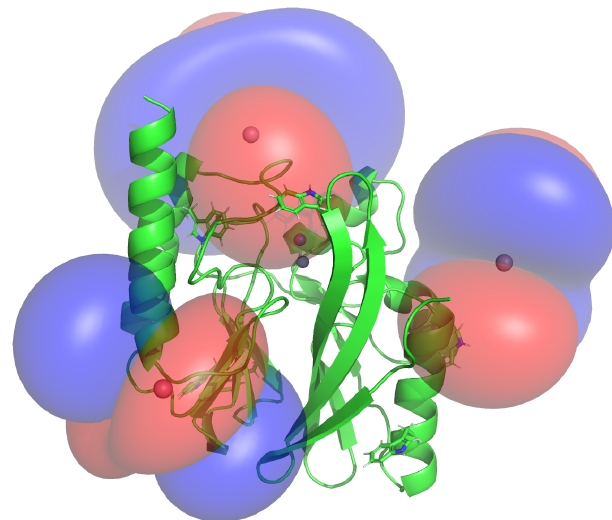
Figure 5. PCS isosurfaces of IMP-1 mutants A53C, N172C and S204C plotted on the crystal structure 5EV6. The respective (cid:49)χ tensors were determined from the 1 H PCSs measured of backbone amides. Blue/red isosurfaces correspond to PCSs of ± 1.0ppm, re- spectively, generated with C2-Tb 3 +